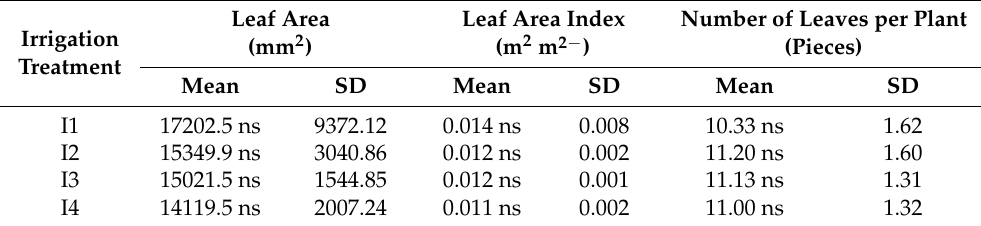
Table 4. Leaf area, leaf area index and average number of leaves per plant of tomato cultivated under different irrigation conditions (I1, I2, I3 and I4); SD = standard deviation; ns = not significant at p > 0.05. Leaf Irrigation